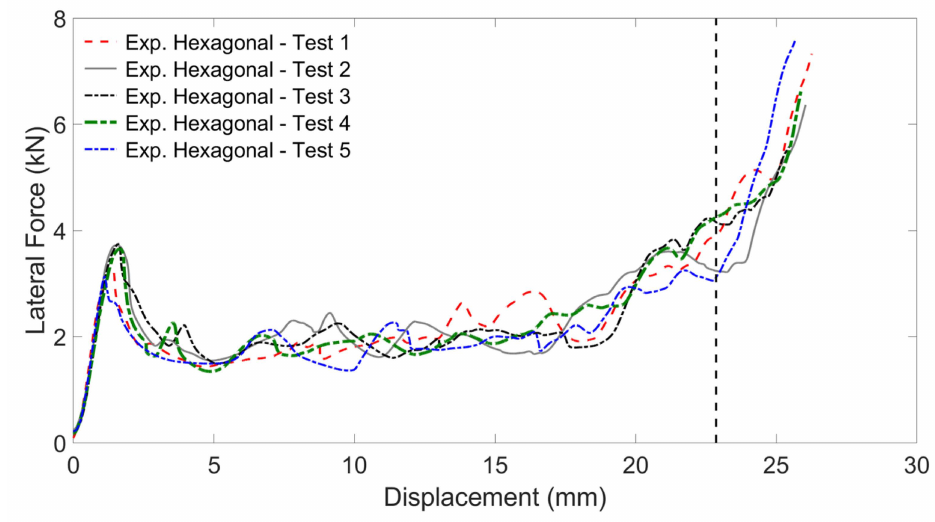
Figure 15. Experimental force-displacement curves of the regular-scale specimens constituted by the hexagonal cell geometry and undergoing lateral load.